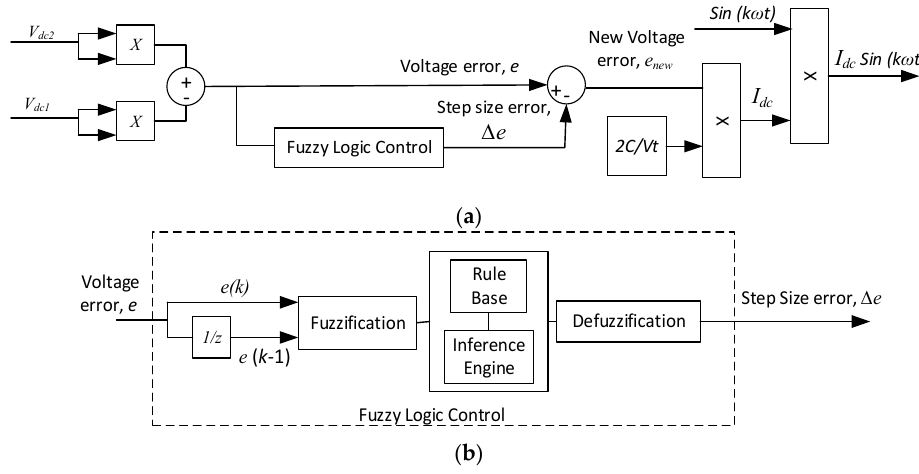
Figure 5. Indirect control in self-charging algorithm: ( a ) block diagram and ( b ) details of Fuzzy Logic Control.